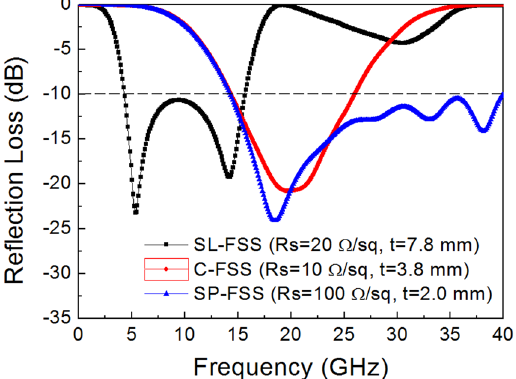
Figure 4. Simulation results of the reflection loss determined for the single-layer FSS absorber with a spacer thickness ( t ) and surface resistance ( R s ) indicated inside the figure.